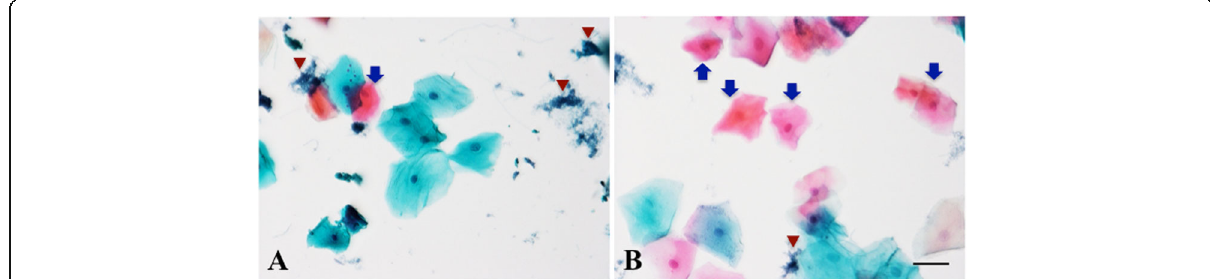
Fig. 1 Exfoliative cells in the human gingiva. Representative images of exfoliative cells, stained with Pap staining, from gingival sulcus ( a ) and free gingiva ( b ). Blue arrows, keratinized cells; red arrow heads, bacterial colonies. Bar = 50 μ